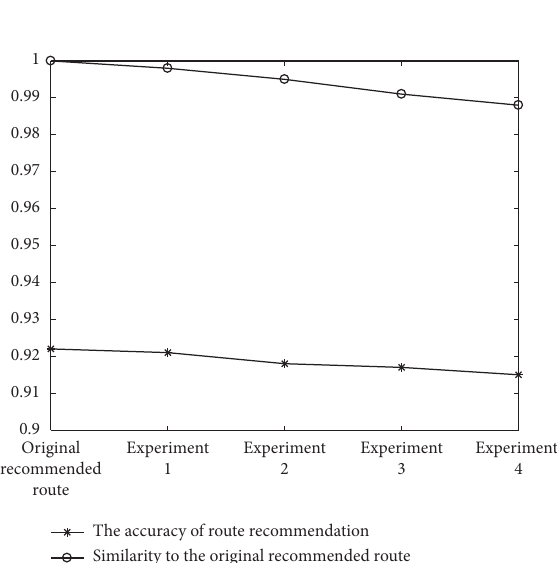
Figure 6: Comparative experiment of the original route with partial sequence